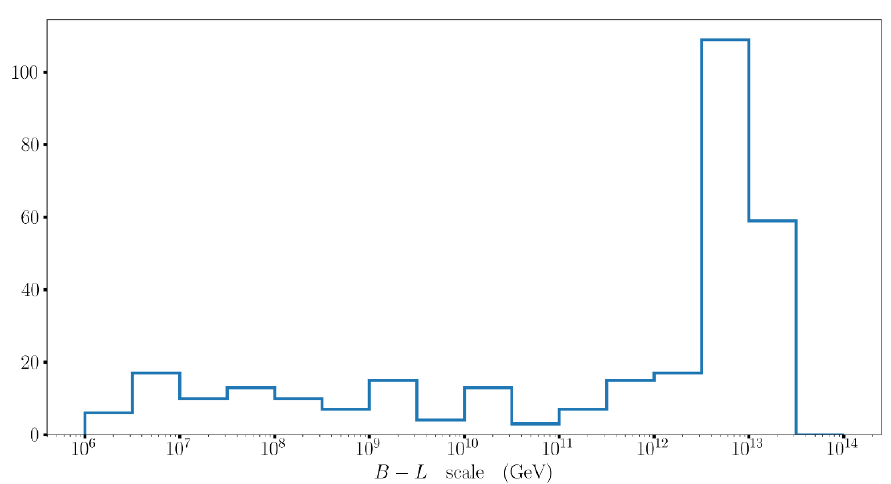
Figure 21. Distribution of the B - L breaking scale for the 305 black points displayed in (cid:12)gure 20.